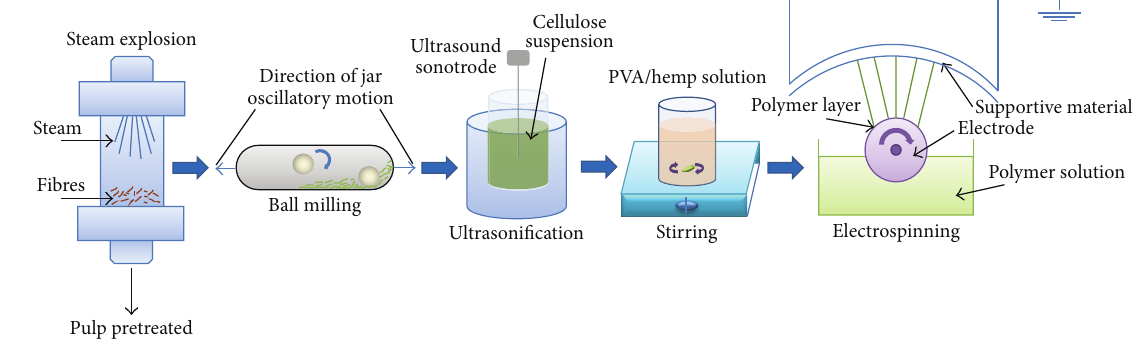
Figure 1: Schematic illustration of the treatment sequence of hemp fibres and shives.